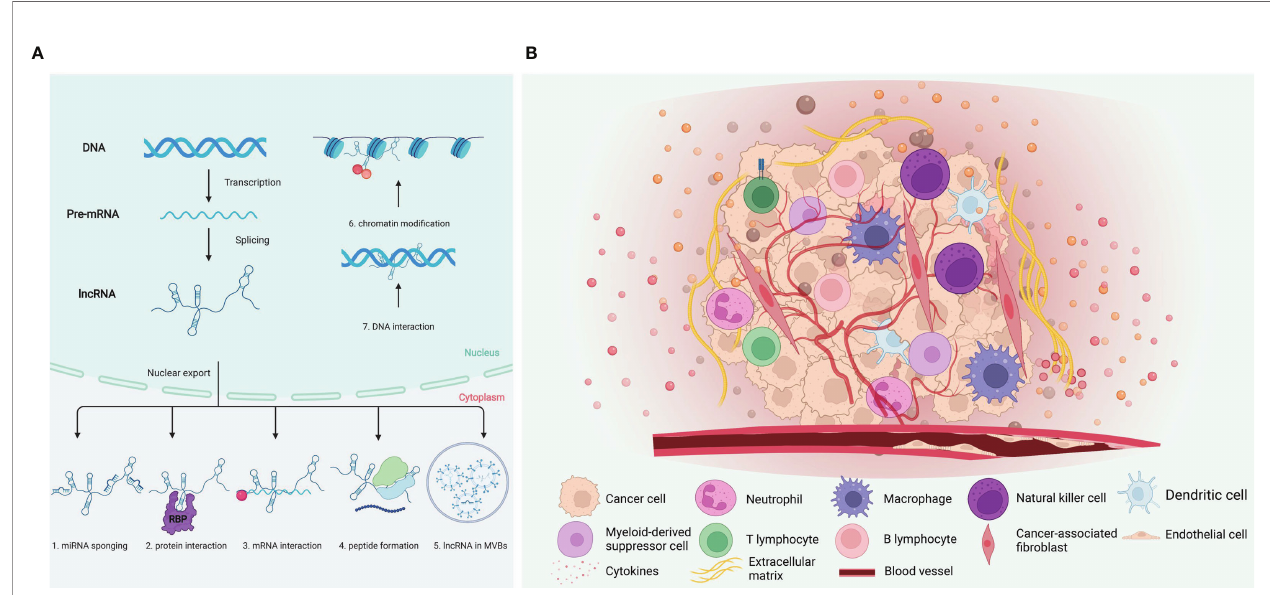
FIGURE 1 | Mechanisms of lncRNA function and tumor immune microenvironment. (A) LncRNA regulate their targets via various mechanisms, including both the transcriptional and post transcriptional levels. (1) MicroRNA sponge; (2) interaction with protein; (3) interaction with mRNA; (4) peptide formation; (5) lncRNA in MVBs; (6) Chromatin modi fi cation; (7) DNA interaction. (B) Components of the tumor immune microenvironment. The tumor immune microenvironment is a complex ecosystem, consist of cancer cells, immune cells, and vascular network, etc. Induced by the cytokines, chemokines, and growth factors, tumor-in fi ltrating immune cells of both the myeloid and lymphoid lineages are recruited and activated. Created with